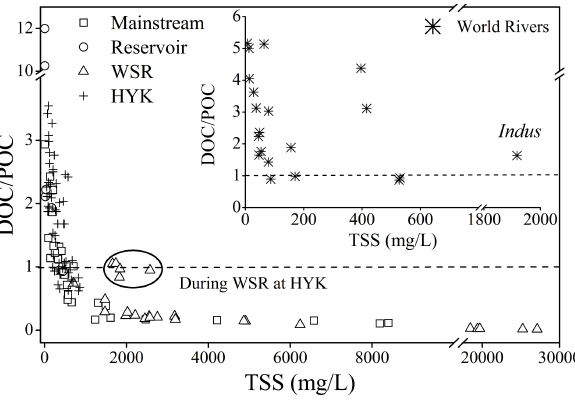
Fig. 8. Relationship between DOC/POC and TSS in the Yellow River and other rivers. WSR denotes the water and sediment reg- ulation scheme of 2008 and HYK indicates the annual observation at the Huayuankou station between November 2005 and Novem- ber 2006 (inset figure shows this relationship for world rivers, with data from Ludwig et al., 1996 and Dagg et al.,